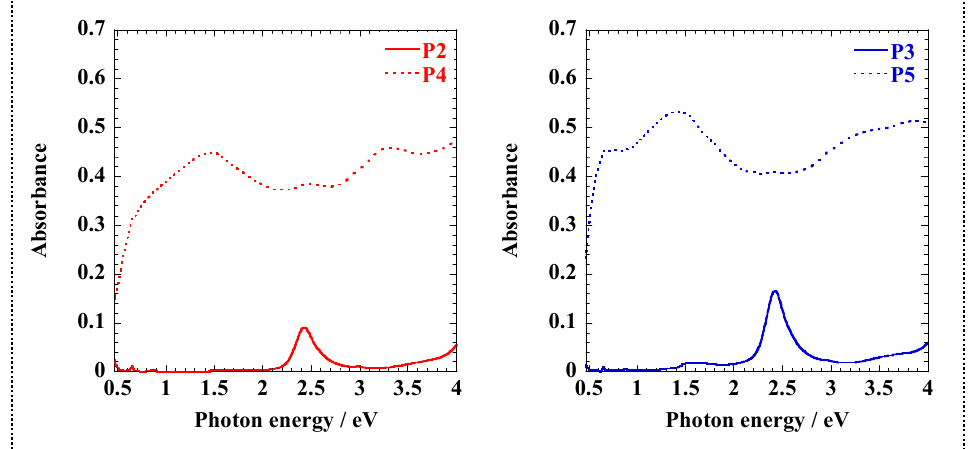
Figure 2. UV-Vis-NIR spectra of P2 – P5 dissolved in phosphate buffer (4.0 g/L).